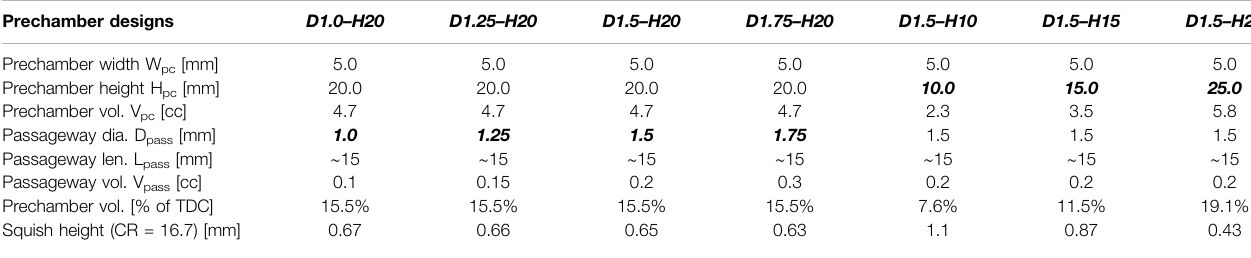
TABLE 4 | Variations of annular prechamber and passageway design simulated with CFD